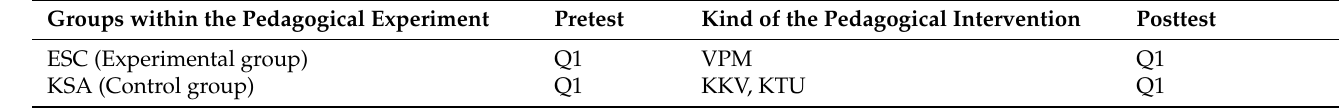
Table 1. Pedagogical experiment